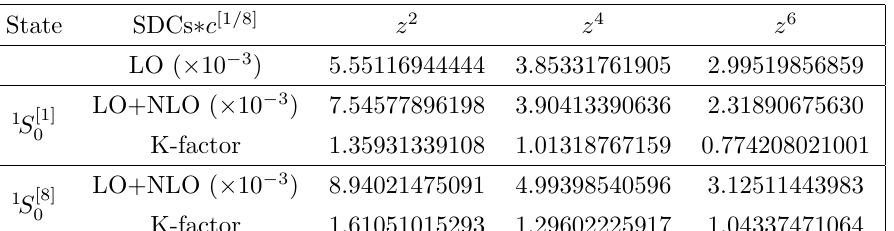
Table 2 . Moments and K-factor of SDCs.